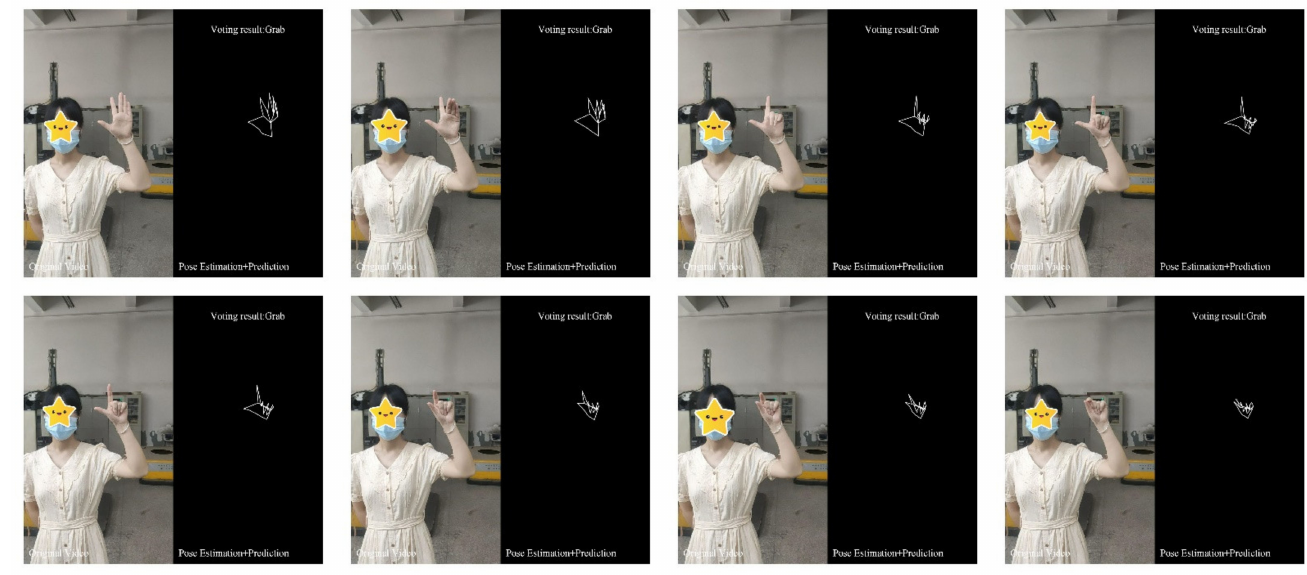
Figure 11. Hand action recognition results (Grab). Figure 12 is the process of hand action recognition of the swipe V action. Based on the coordinate information of hand joints, hand action recognition is realized by using the hand action recognition model based on the NST-GCN network.